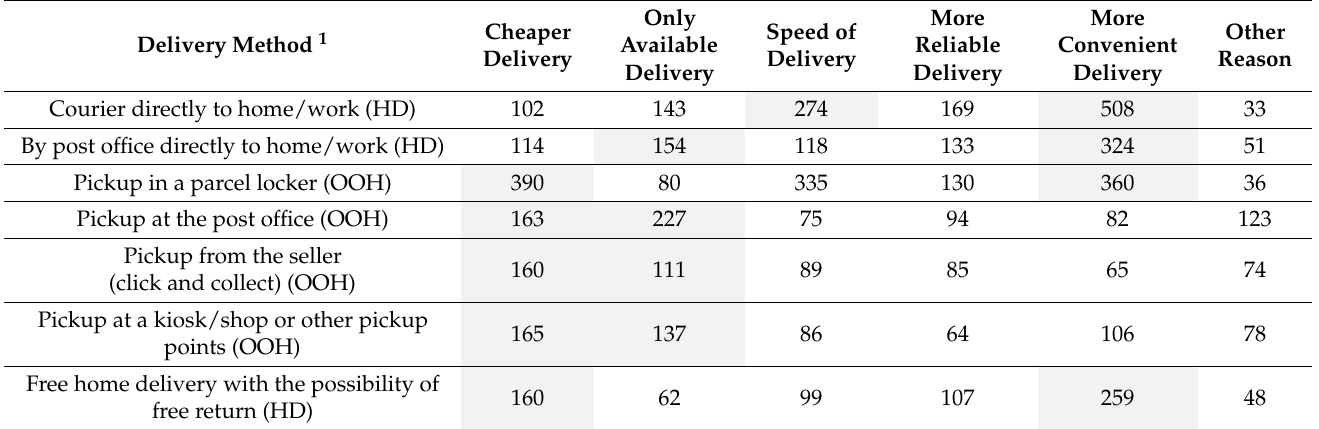
Table 3. Reasons for the choice of the delivery method by rural e-customers (own